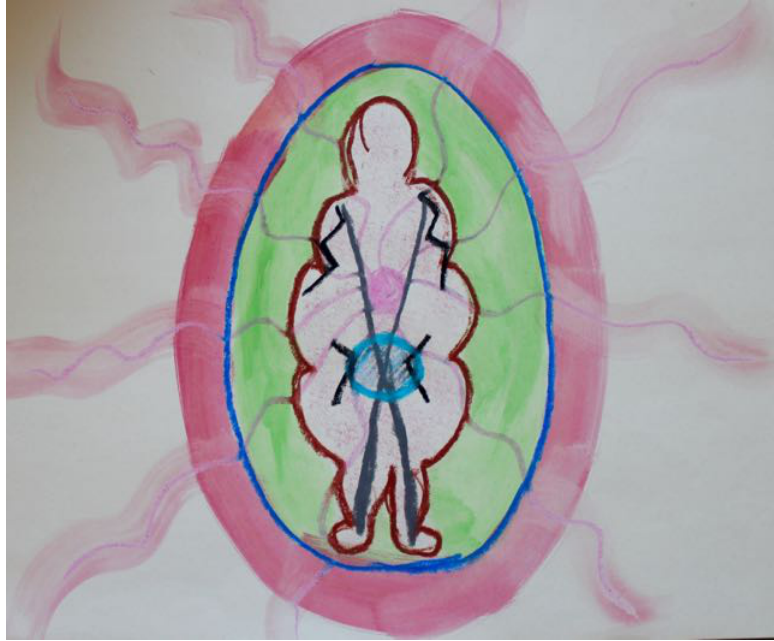
FFigigururee 2.2. CClientlient picturpicturee befbefororee trtreeatmentatment AG: They strapped me. They made me mushy.